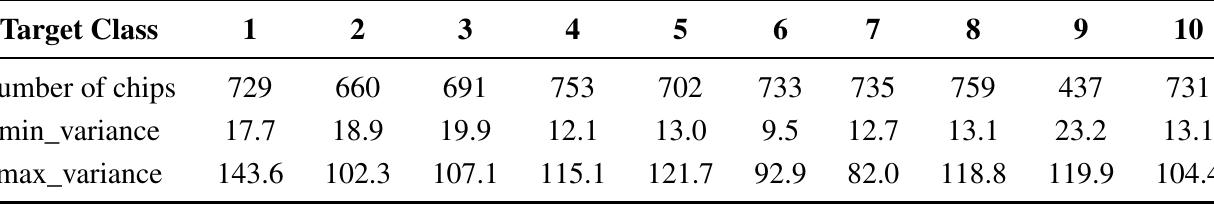
Table 10. The variance range of each target class.